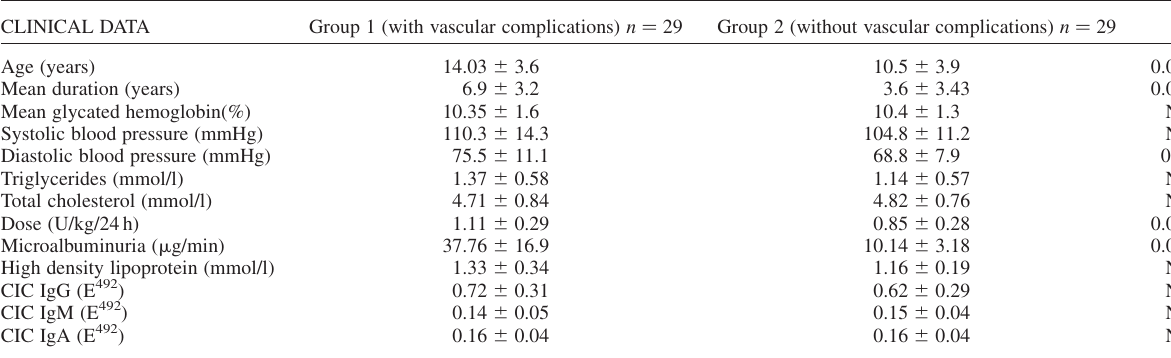
TABLE II Clinical characteristics of diabetic patients with or without vascular complications CLINICAL DATA